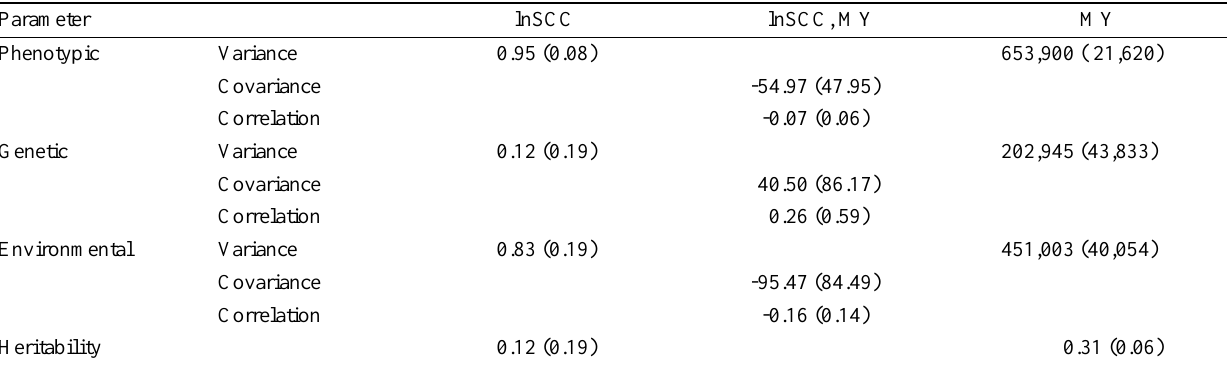
Table 1. Variance components, phenotypic correlations, genetic correlations and heritabilities for natural logarithm of somatic cell count (lnSCC) and milk yield (MY) standard errors are in brackets Parameter